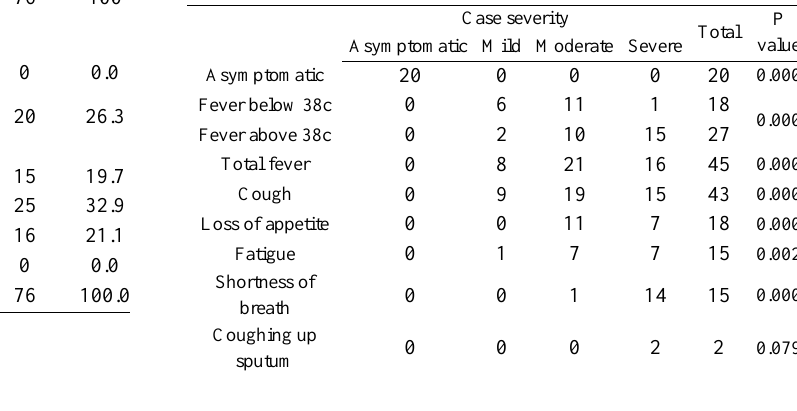
Table 3: Symptoms and case